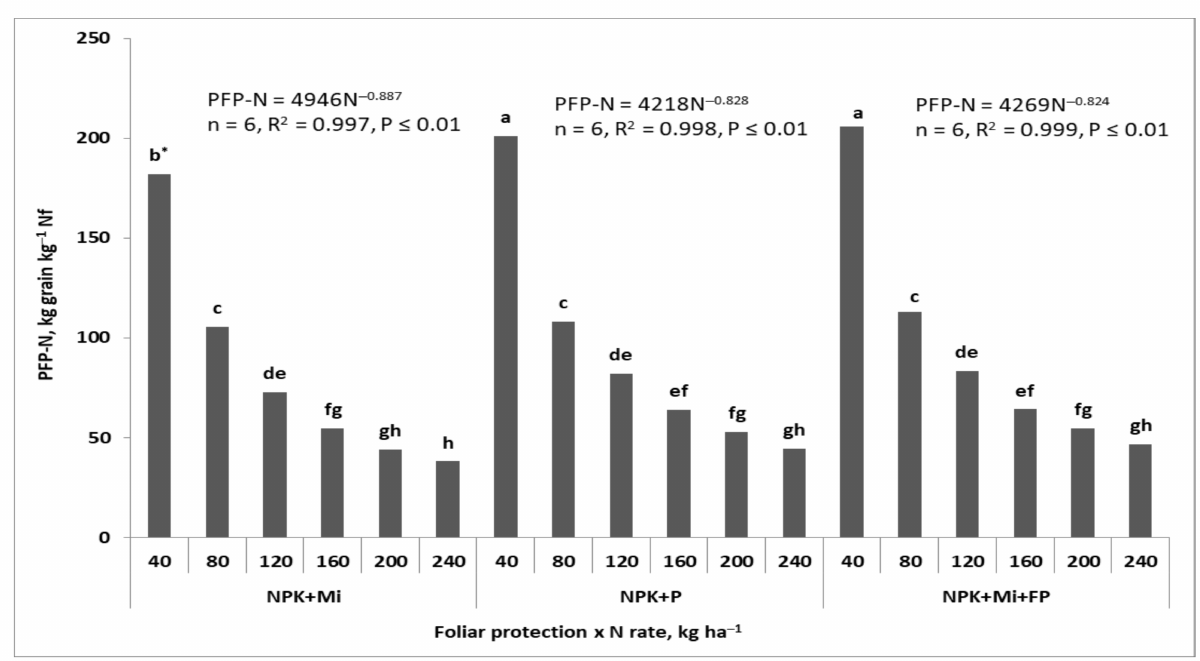
Figure 4. Response of Partial Factor Productivity of fertilizer N by winter wheat to interaction of foliar protection systems and N rates. * Similar letters means a lack of significant differences using Tukeys’ test. Legend: N + Mi—N and micronutrients; N + P—N + fungicides; N + Mi + P—N plus micronutrients and